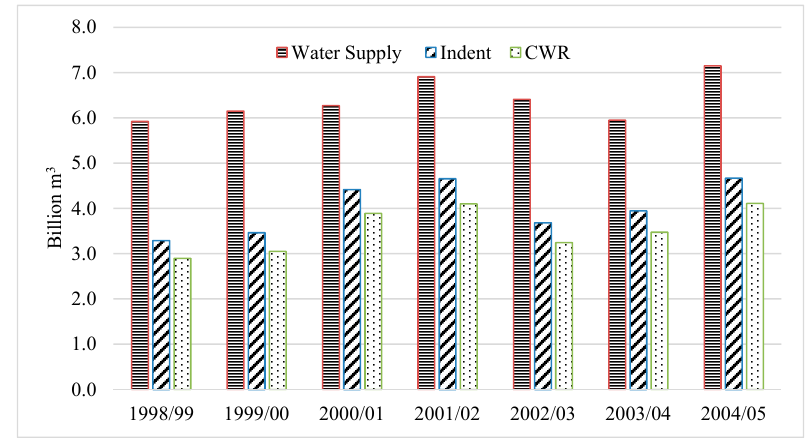
Figure 6. Water supply volume against Indent and CWR at SGB and MOIWR period.